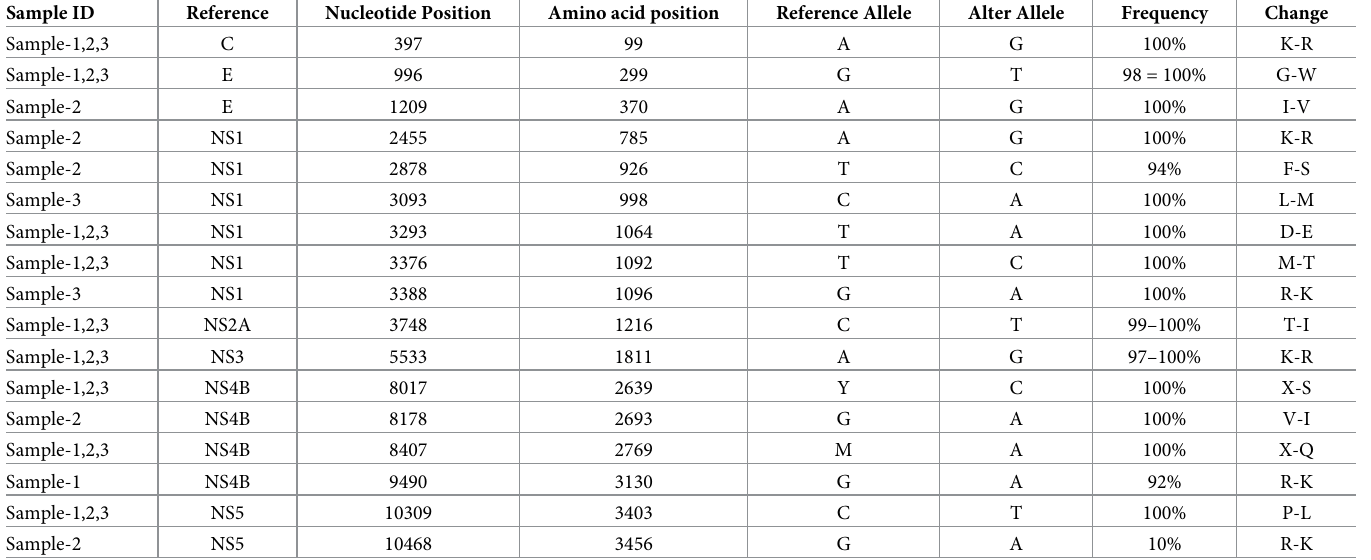
Table 6. Non-synonymous variant ( > 1%) alleles shared among the DENV-4 isolates in this